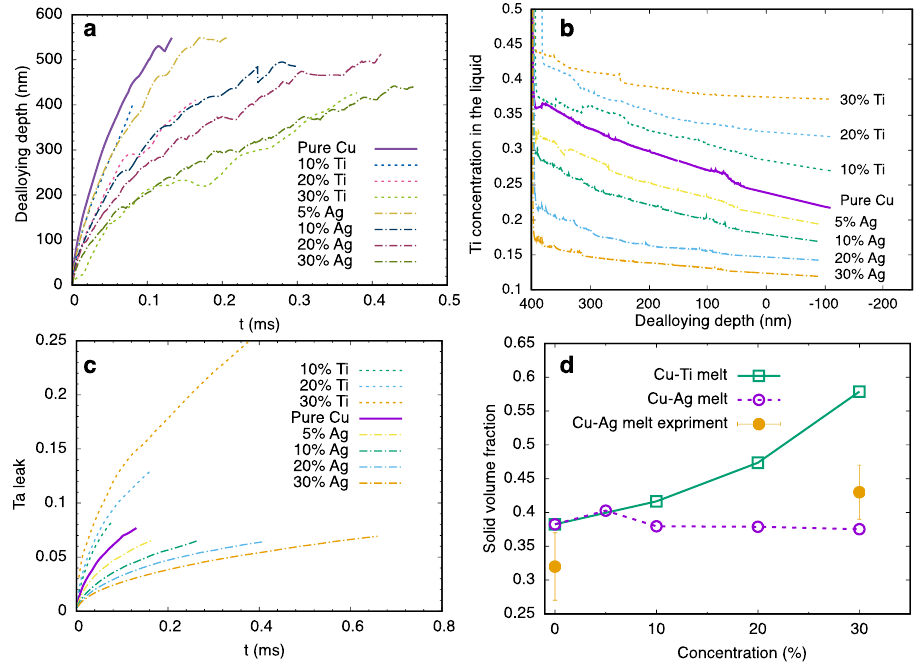
Fig. 3 Effect of melt composition on dealloying kinetics and compositional evolution. Phase- fi eld simulations of dealloying of Ta 15 Ti 85 alloys quantifying the distinct effects of Ti and Ag addition to Cu melts on dealloying kinetics measured by dealloying depth versus time ( a ), Ti concentration pro fi les in the liquid at a dealloying depth of 400 nm (Negative depths extend in the melt region outside the dealloyed structure. The dealloying front is at left). b Ta leak versus time ( c ), and solid fraction of dealloyed structures as a function of melt composition ( d ). The x axis in ( d ) is the concentration of the additional element (Ti for the green line and Ag for the purple line and experiment) in the